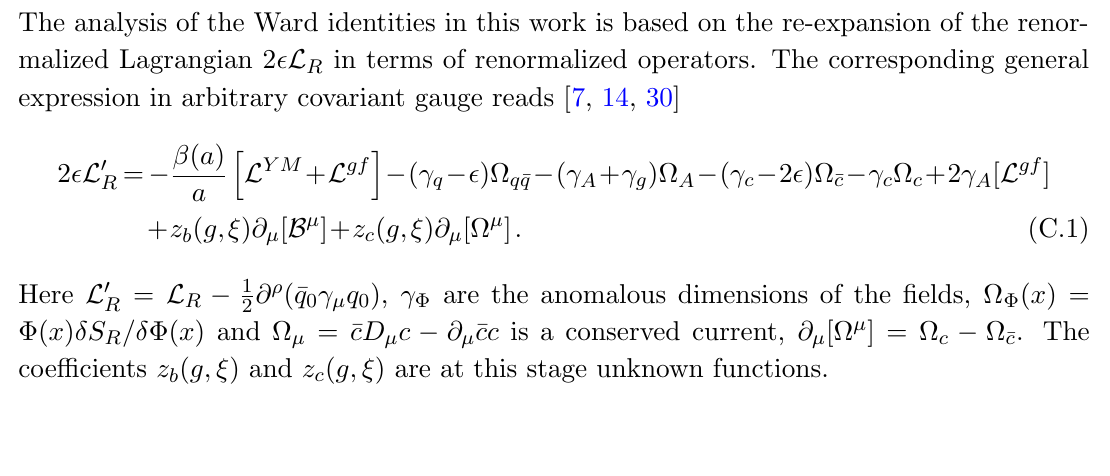
(cid:0) z ) O ( z ; z ) that cancels in the sum with 1 2 g 1 2